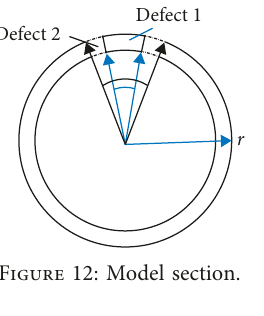
Figure 12: Model